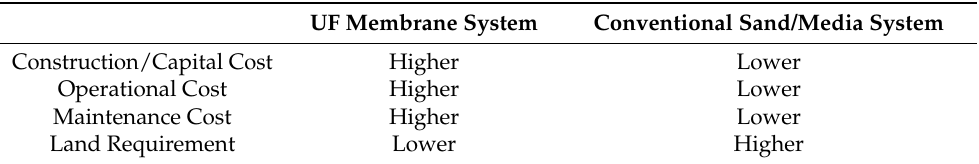
Table 3. General costs comparison between UF membrane and conventional sand/media water treatment